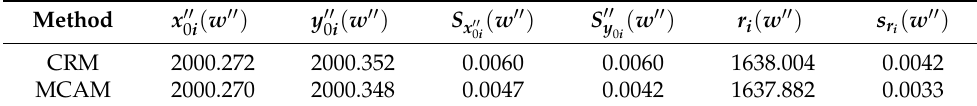
Table 4. Calculation results of ring information using two circle fitting methods ( i best = 9).